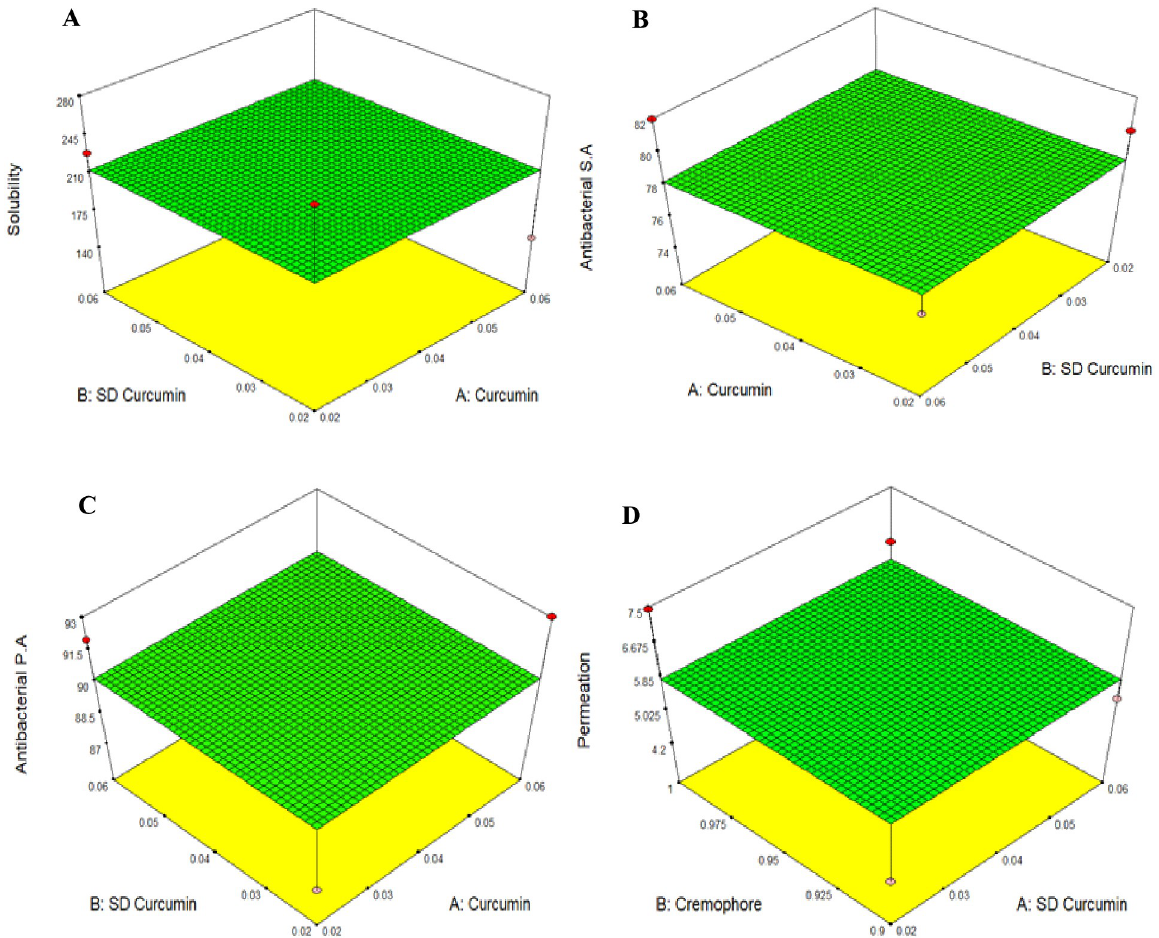
Fig 3. Comparative evaluation of effect of CUR and PEG-CUR (A) on solubility (B, C) antibacterial effect and (D) Cremophore as permeation enhancer for selection of ointment formulations.